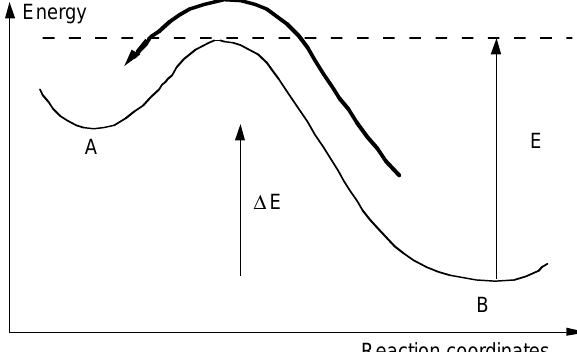
Figure 24. Reaction pathway for reverse